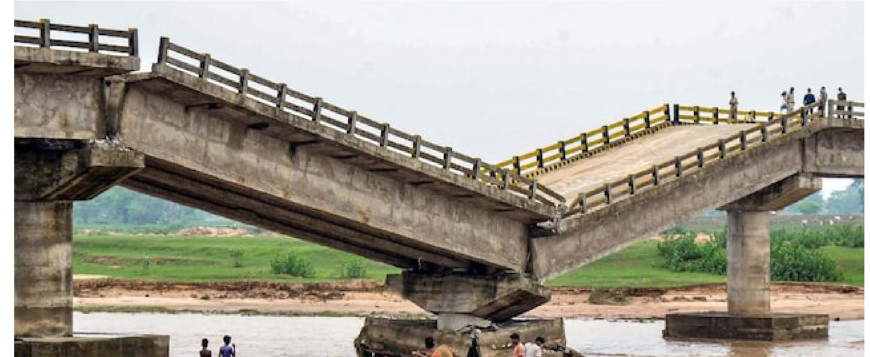
Fig. 14 Collapse of bridge due to column removal in